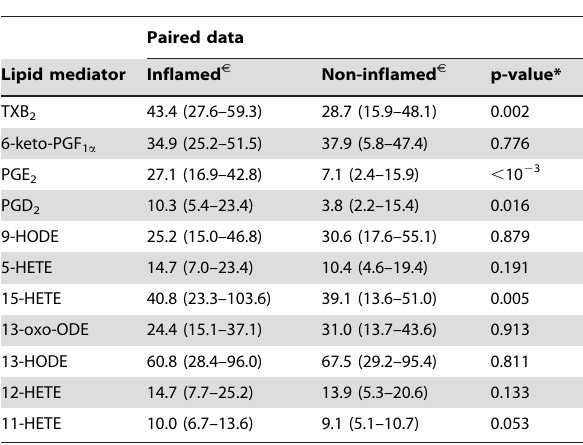
Table 3. Lipid mediator concentrations (pg/mg tissue) in colonic mucosa (inflamed and non-inflamed) in treatment naive